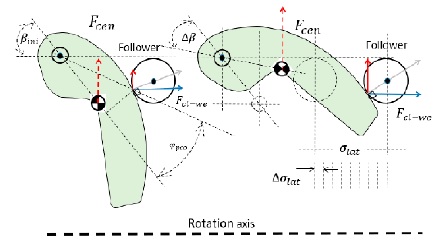
Figure 11. Lateral force principle by flyweight cam. Appl. Sci. 2020 , 10 , x FOR PEER REVIEW